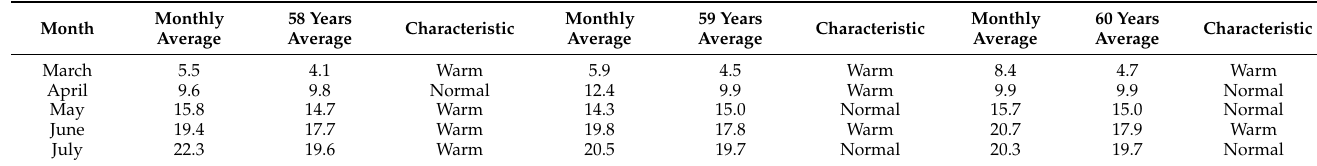
Table 2. ARDS Turda thermal regime ( ◦ C) during 2015–2017.